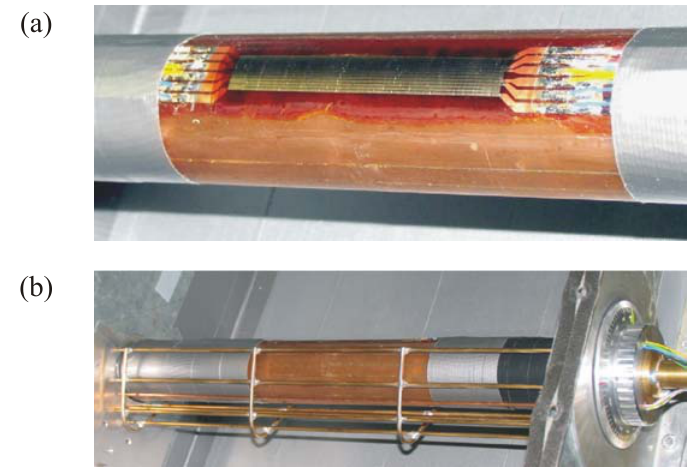
Figure 8. View into the wind tunnel test section. (a) Circular cylinder with mounted triple sensor; configuration for low turbulent flow field (LT). (b) Upstream mounted turbulence generators; configuration for high turbulent flow field